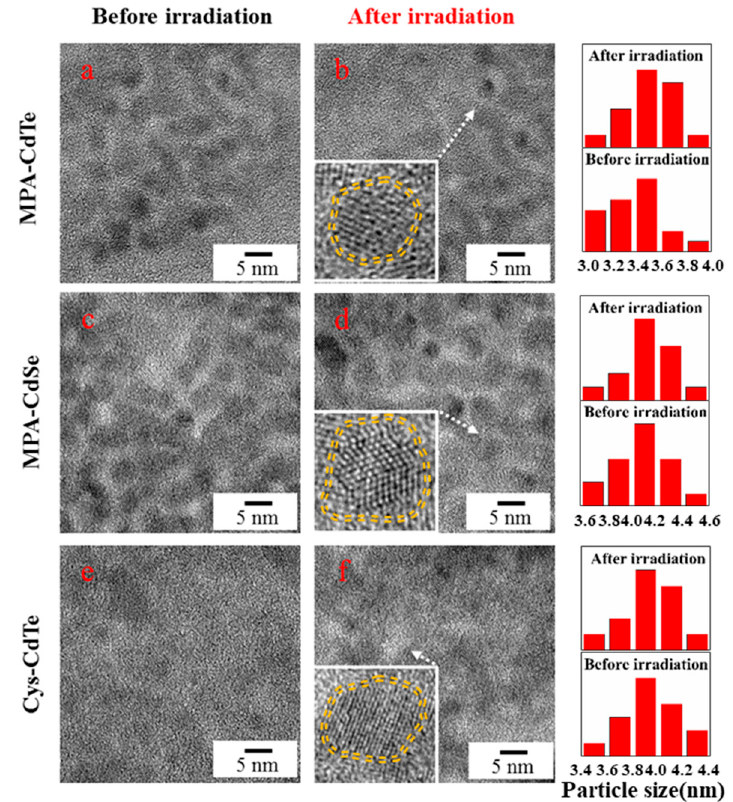
Figure 4. TEM images and size distributions of MPA-CdTe ( a , b ), MPA-CdSe ( c , d ) and Cys-CdTe ( e , f ) QDsbefore and after 10 kGy γ -irradiation.